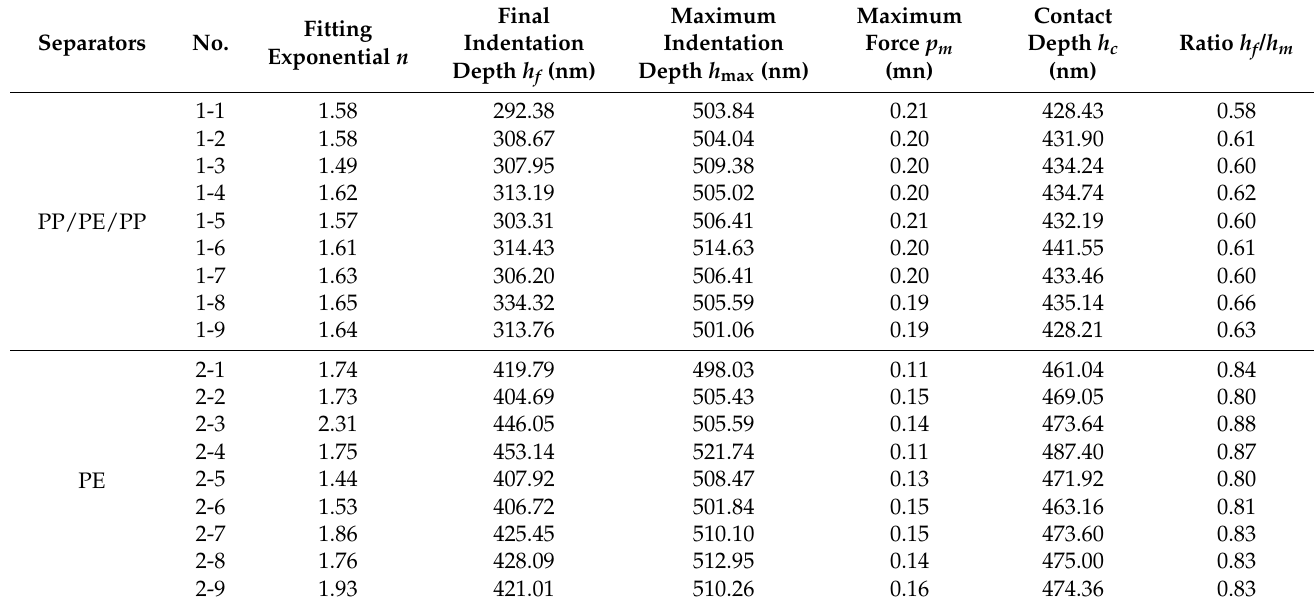
Table A1. Nanoindentation experiment data of specimens.